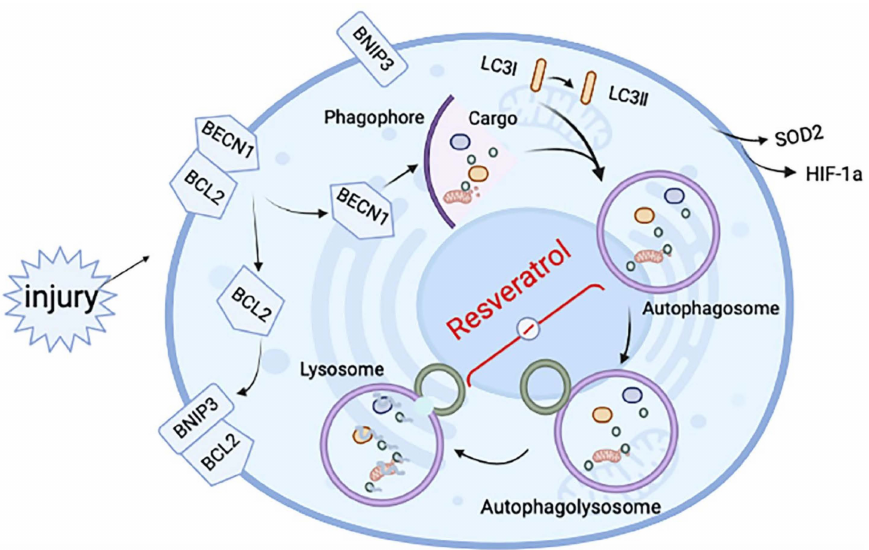
Figure 6. Schematic diagram of the mechanisms underlying resveratrol’s effect on induced RA-ILD. After tissue injury, hypoxia-related proteins change in the hypoxic microenvironment, making BNIP3 competitively bind BCL2 and release BCL2-bound BECN1, thus inducing autophagy. After autophagy is initiated, autophagosomes are formed, but the fusion with lysosomes to form autophagosomes is hindered. The effect of resveratrol is mainly in the fusion process of autophagosome and lysosome, to relieve the inhibition state and improve